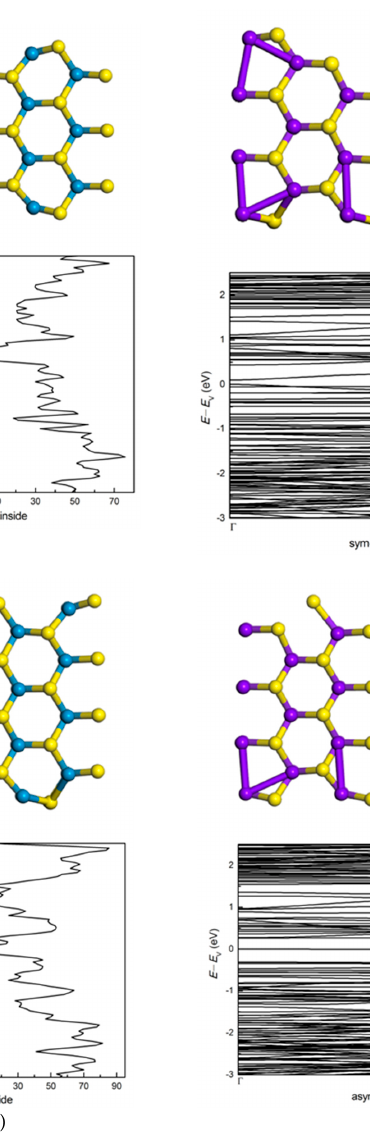
Figure 14. The relaxed geometry, band structure and dos of symmetric and asymmetric (MoS 2 ) 3 /(WS 2 ) 3 armchair nanoribbons with Mo vacancy. ( a ) symmetric structure with inside Mo vacancy and ( b ) symmet- ric structure with edge Mo vacancy. ( c ) asymmetric structure with inside Mo vacancy and ( d ) asymmetric structure with edge Mo